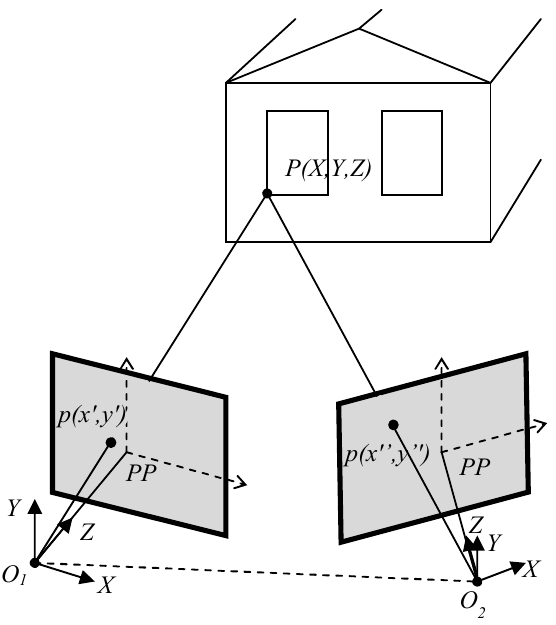
Figure 2. Close-range stereo photogrammetric